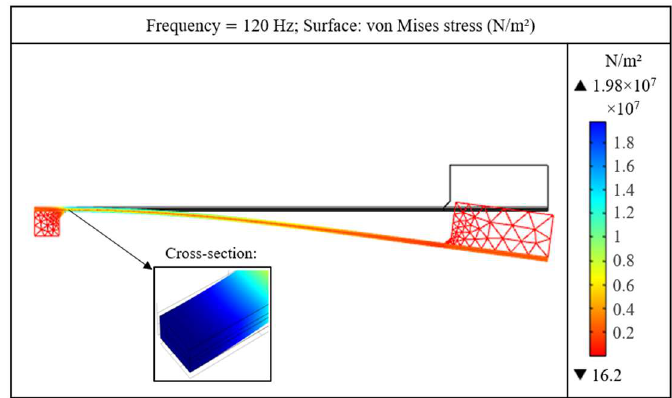
Figure 6. Stress distribution of the optimised CB at 120 Hz.